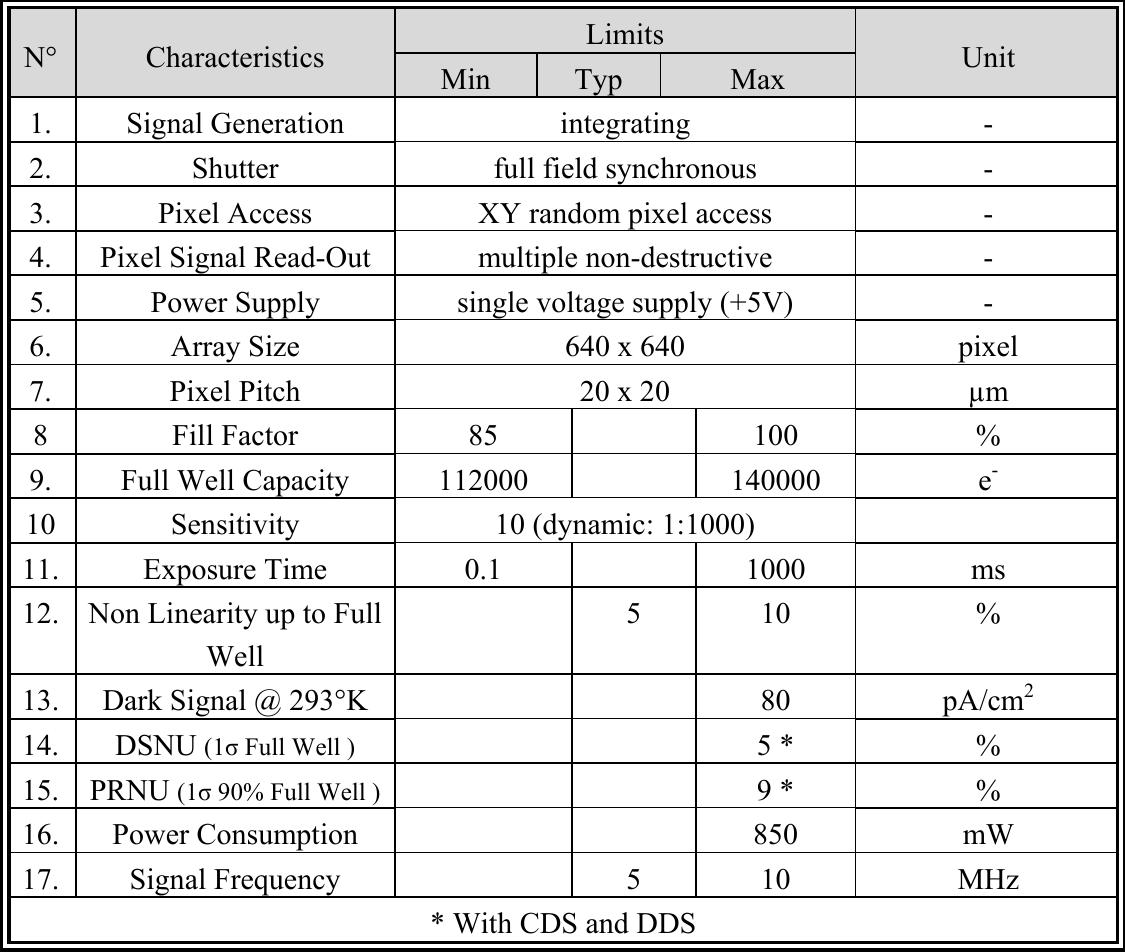
Table 2. Main APS for star sensor parameters